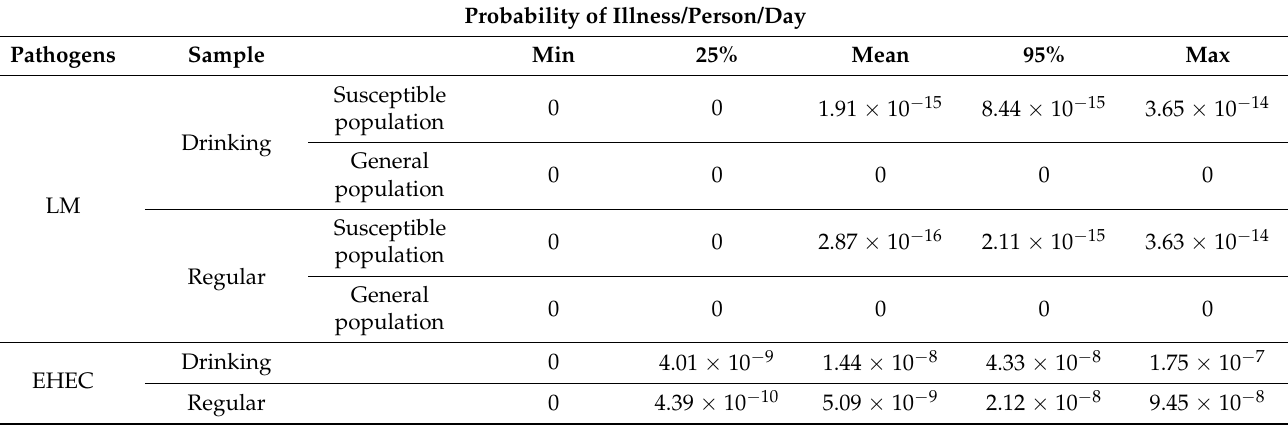
Table 4. Probability of illness per day per person by Listeria monocytogenes (LM) and EHEC with consumption of yogurt with @Risk